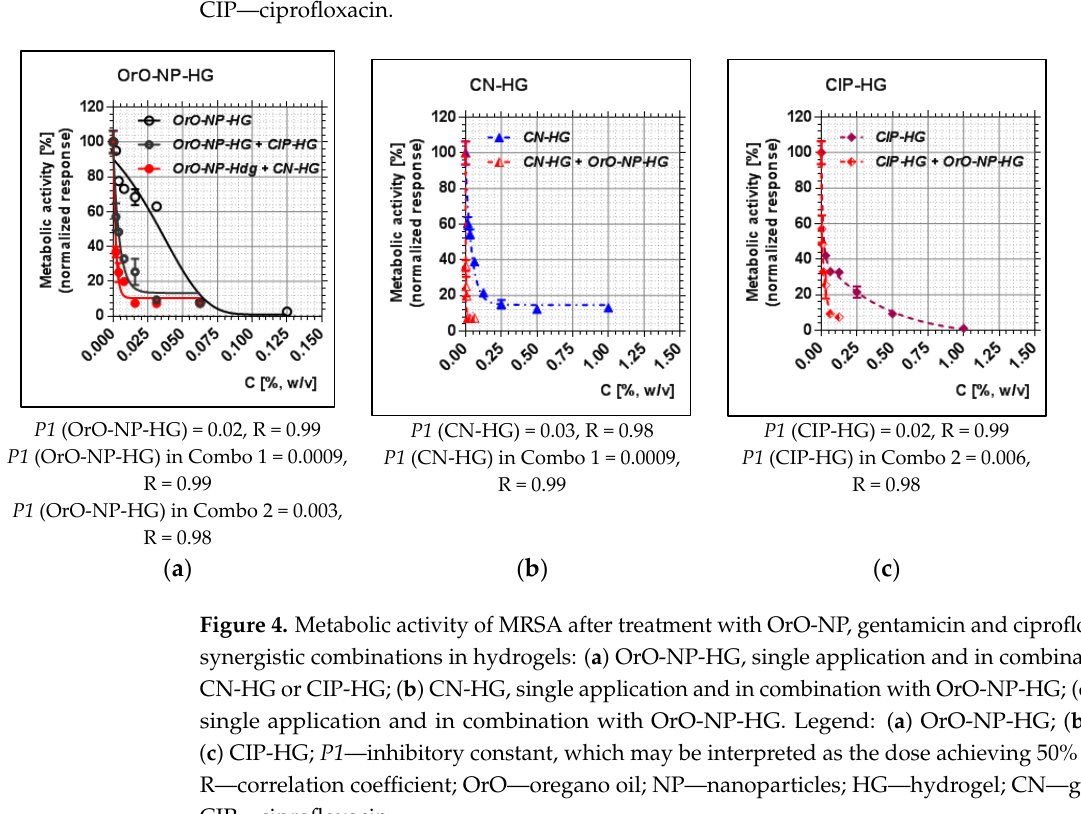
Figure 3. Metabolic activity of MSSA after treatment with OrO-NP, gentamicin and ciprofloxacin and synergistic combinations in hydrogels: ( a ) OrO-NP-HG, single application and in combinations with CN-HG or CIP-HG; ( b ) CN-HG, single application and in combination with OrO-NP-HG; ( c ) CIP-HG, single application and in combination with OrO-NP-HG. Legend: ( a ) OrO-NP-HG; ( b ) CN- HG; ( c ) CIP-HG; P1 — inhibitory constant, which may be interpreted as the dose achieving 50% inhibition; R — correlation coefficient; OrO — oregano oil; NP — nanoparticles; HG — hydrogel; CN — gentamicin; CIP — ciprofloxacin.